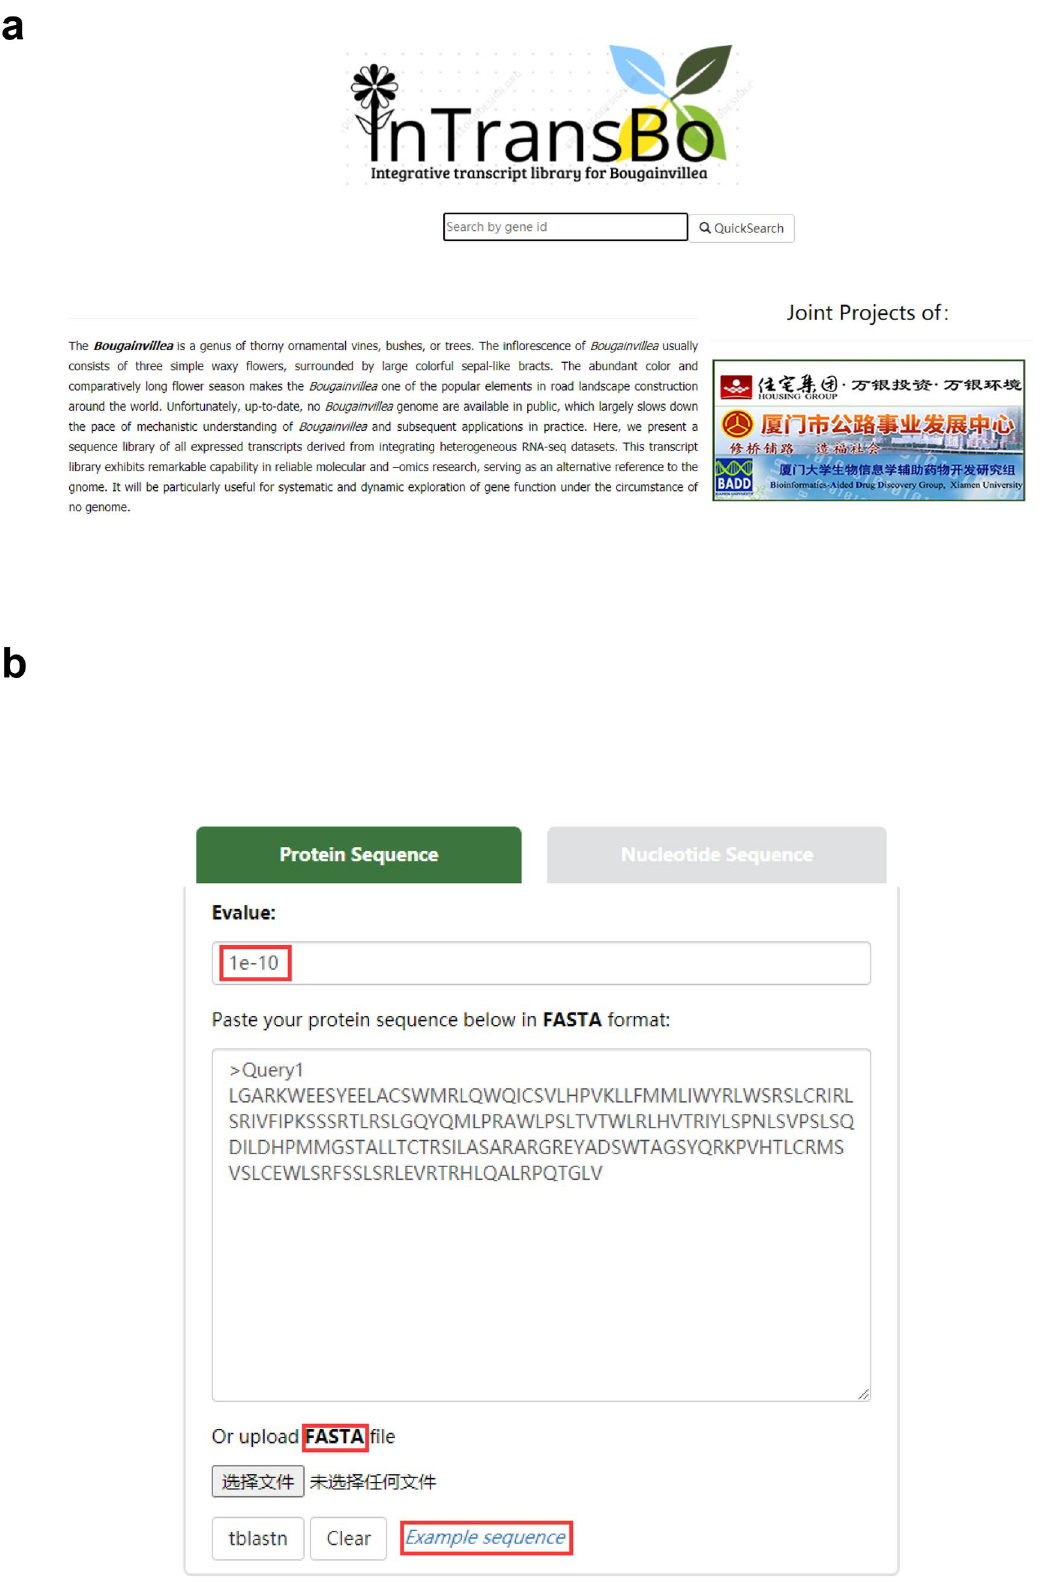
Figure 2. Snapshots of InTransBo user interfaces. ( a ) Homepage and keyword search form. ( b ) BLAST search